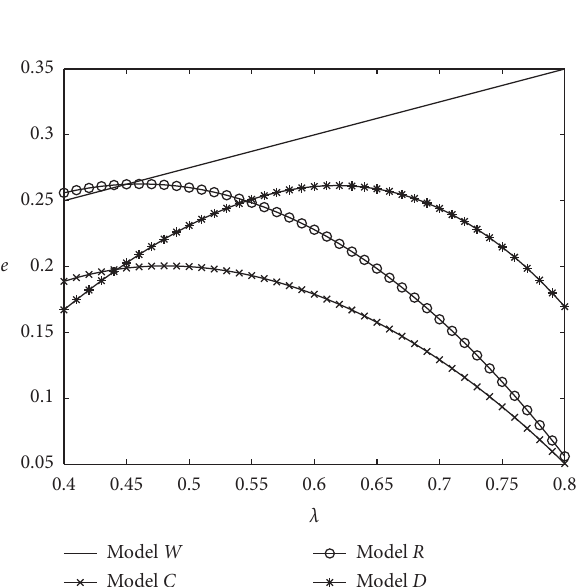
Figure 5: The impact of λ on profit.